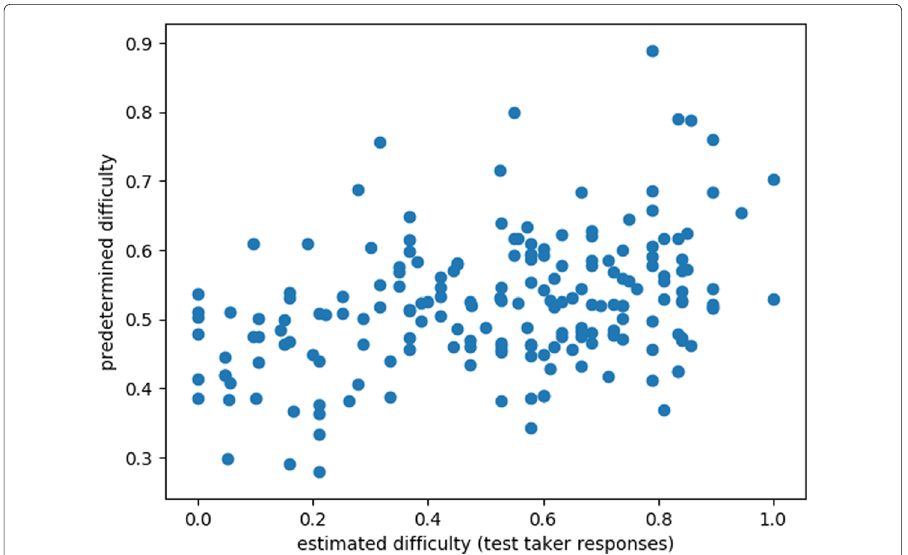
than the gold standard, but the difference is not that great. This result is encouraging for incorporating a predetermined item difficulty into CAT since it indicates that even only with four levels of the predetermined item difficulty, it performed relatively better than the linear